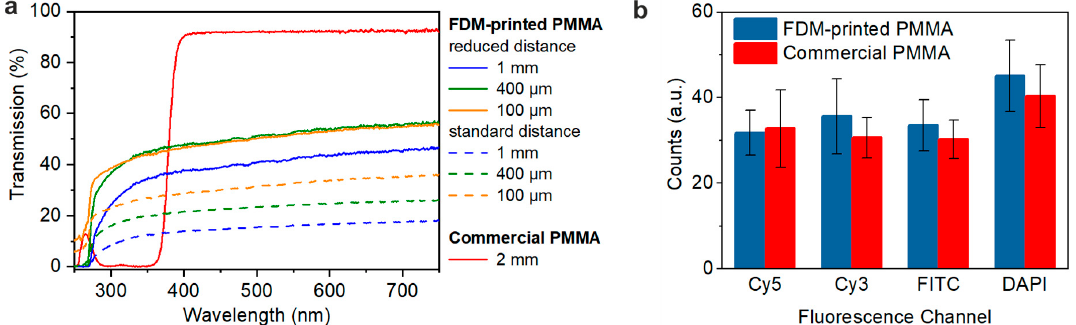
Figure 5. Characterization of FDM printed PMMA. ( a ) UV-Vis measurement of printed PMMA using di ff erent printing strategies (standard and reduced nozzle distance) and commercial PMMA substrates. ( b ) Fluorescence intensity of commercial PMMA substrate and FDM printed